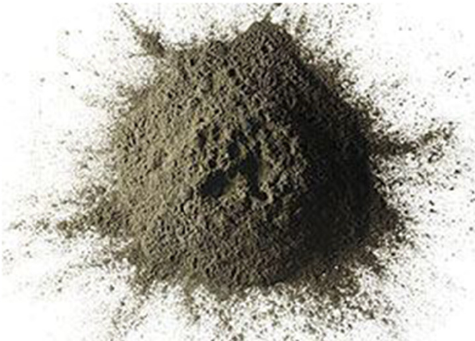
Figure 1. Fly ash from Holboca Electric Power Plant.